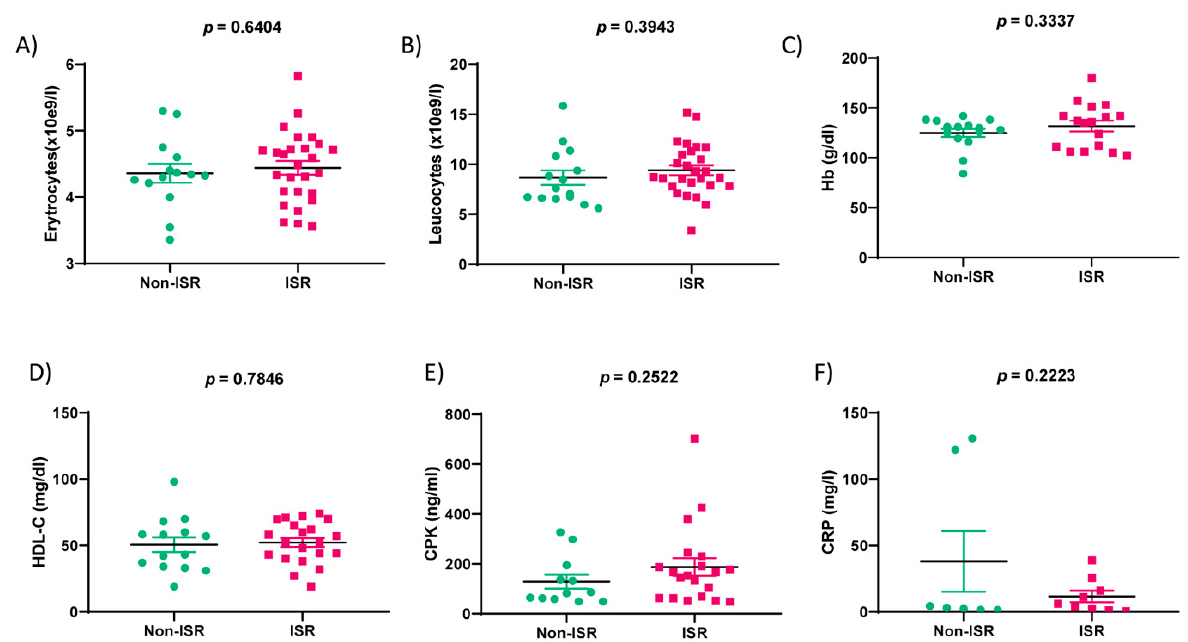
Figure 3. Hemodynamic parameters of the non-ISR (green) and ISR (rose) patients’ groups. Bar graphs show the concentration/levels of erythrocytes ( A ), leukocytes ( B ), hemoglobin (Hb) ( C ), High-Density Lipoprotein cholesterol (HDL-C) ( D ), Creatine phosphokinase (CPK) ( E ), C-Reactive Protein (CRP) ( F ) assessed in the serum sample collected from the non-ISR and ISR patients. Values are the means ± S.E.M.